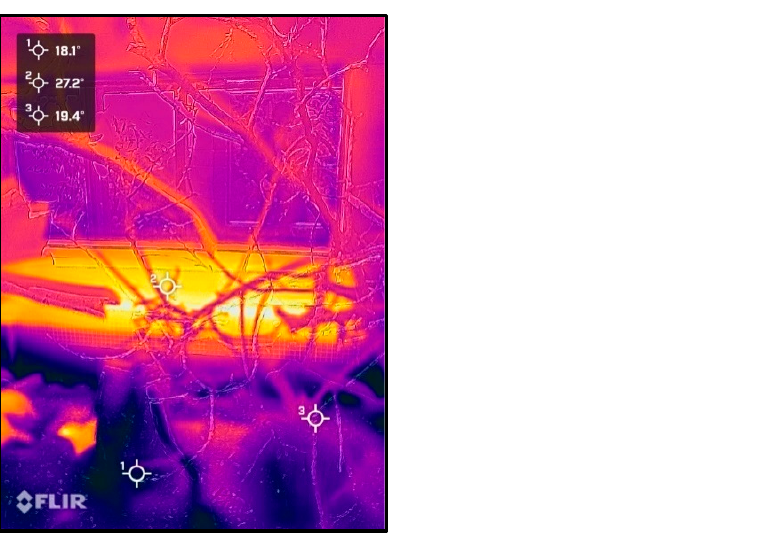
Figure 4. Image from the inside area of the C. obscurus enclosure. FLIR thermal image of bar heater reading 27.2 °C (as indicated by the white crosshairs numbered 2) and floor temperature reading 18.1–19.4 °C (as indicated by the white crosshairs numbered 1 and 3).